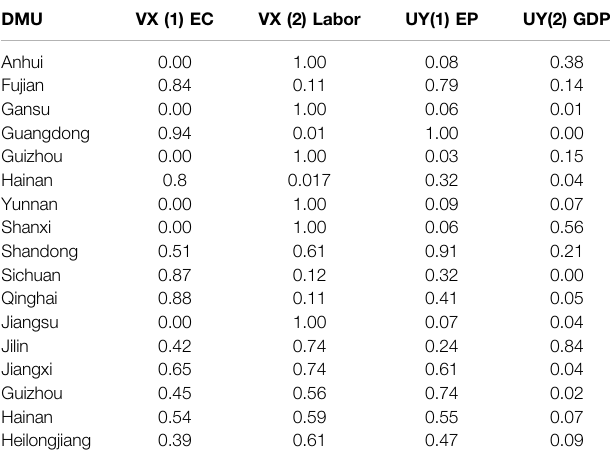
TABLE 2 | Weighted data. TABLE 3 | Energy poverty index